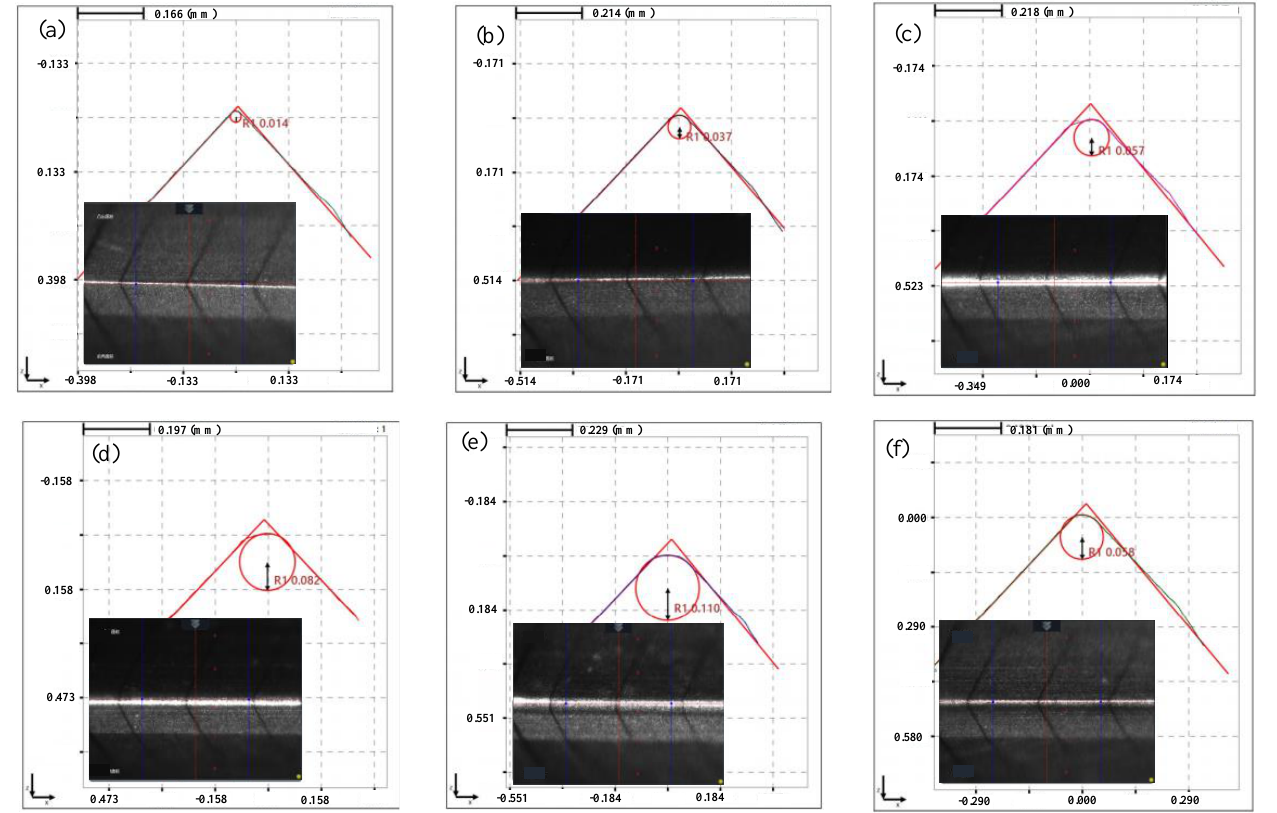
Figure 9. The change of the shape factor K with the polishing angle.